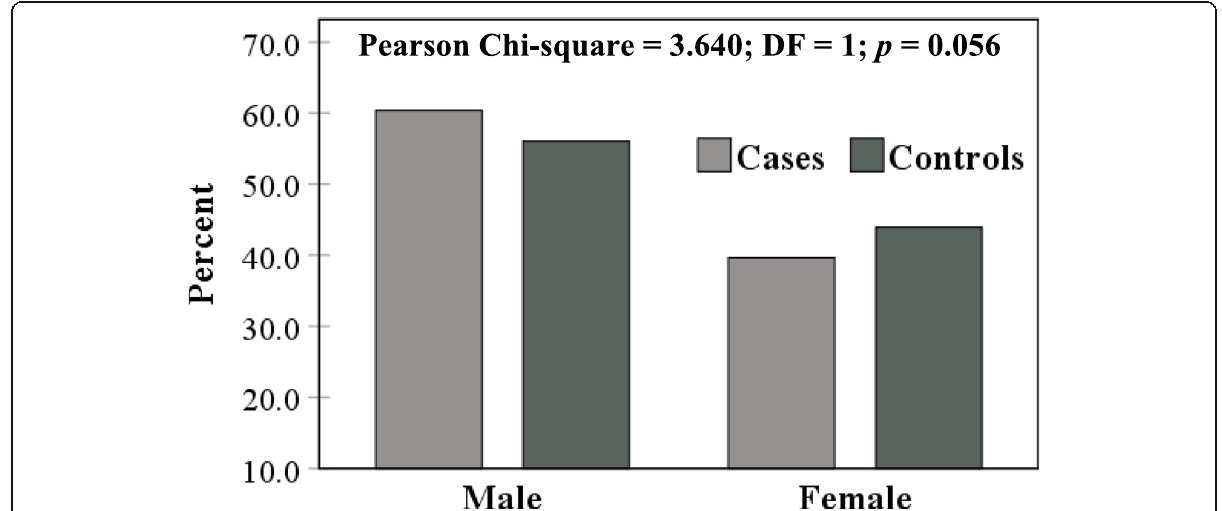
Fig. 4 Gender distribution of COVID-19 cases and controls